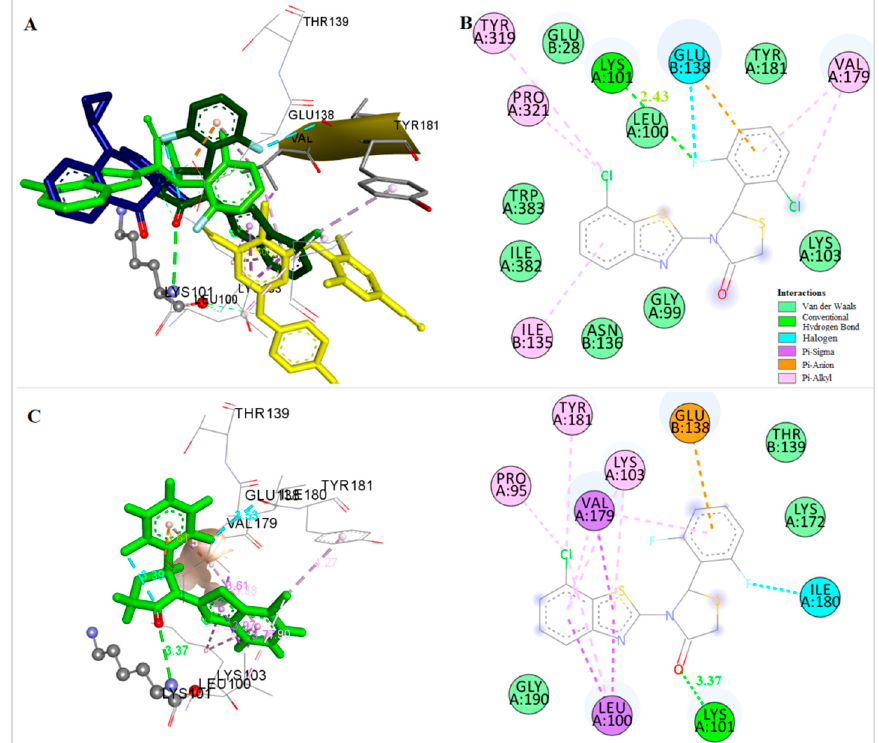
Figure 7. ( A ). Docking of Compounds 1 (dark green), 2 (light green), Nevirapine (dark blue) and Etravirine (yellow) at the Allosteric Site of HIV-1 RT. ( B ). Docking of Compound 2 at the Allosteric Site of HIV-1 RT. ( C ). Docking of Compound 1 at the Allosteric Site of HIV-1 RT.